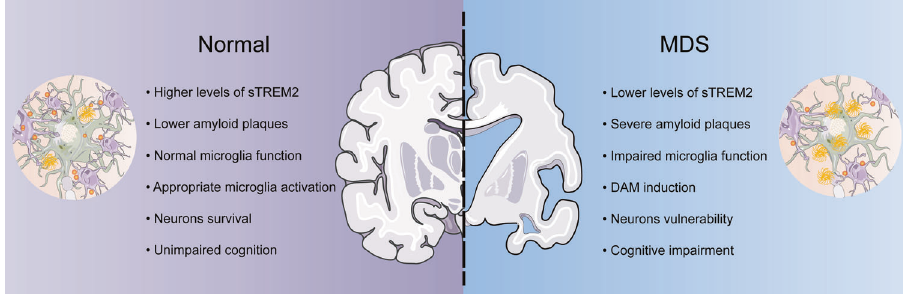
Fig. 4 The role of CSF sTREM2 in MDS. The schematic graph is depicting the characteristic of association of MDS with CSF sTREM2 based on this study and current research in this fi led. CSF cerebrospinal fl uid; DAM disease-associated microglia; sTREM2 soluble of trigging receptor expressed on myeloid cells 2; MDS minimal depressive symptom.